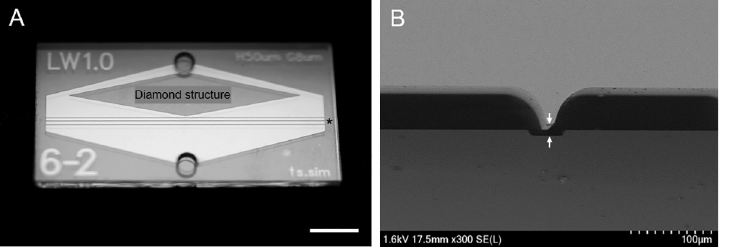
Fig 3. Fabricated microslit filter chip. ( A ) An image of the microslit filter chip. The asterisk ( � ) indicates microslit filter area and a diamond shape structure is located to make uniform flow distribution between the inlet port and slit area, respectively. Scale bar, 5 mm. ( B ) A cross-section view: scanning electron microscope image of the microslit device (scale bar: 100 μ m). The white arrows indicate the depth of microslit and the value was 8.10 μ m in